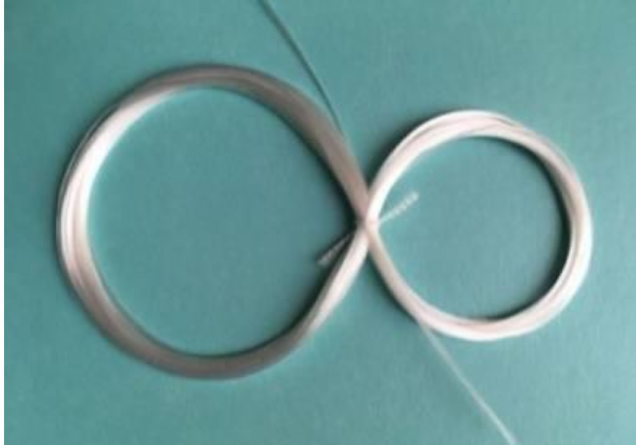
Figure 3. PET industrial filaments used in this